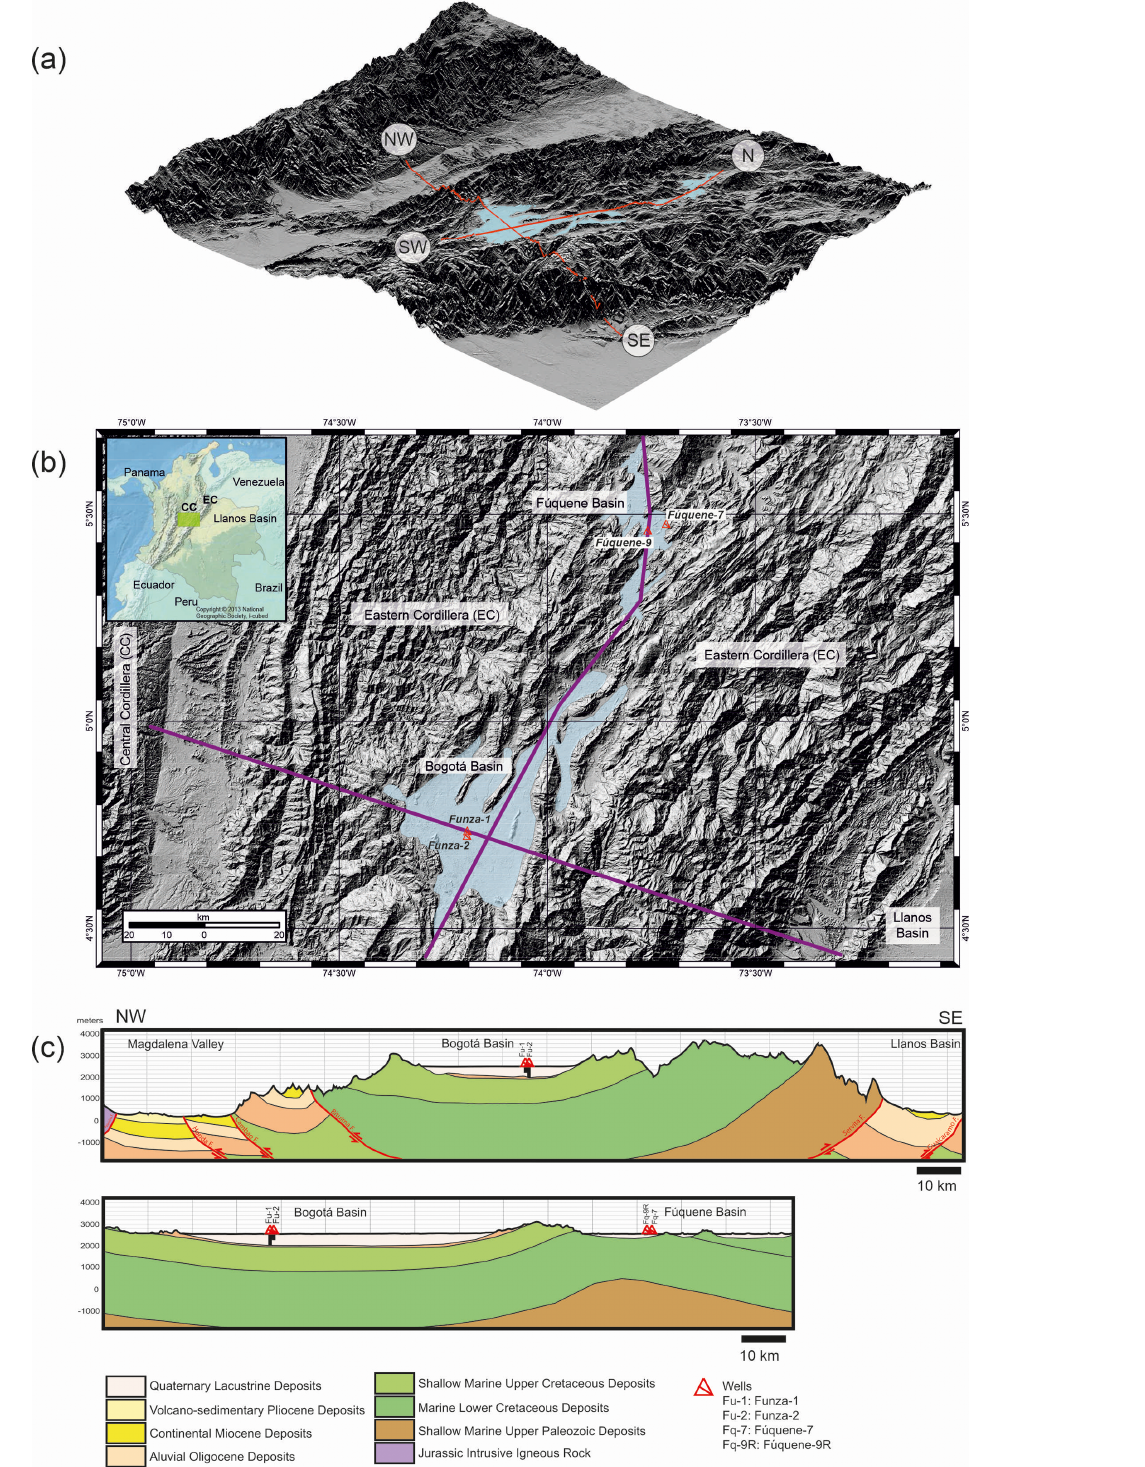
Figure 4. Cross section (a) and top view (b) of the Bogotá basin at 2550ma.s.l. (above sea level) in the Eastern Cordillera, Colombia. During the early Quaternary, an accelerated subsidence of the basin floor gave rise to the development of the ancient Lake Bogotá. The lower sediment infill contains gravels, sands, silty clays, and lignite horizons. The middle and upper part of the sediments are lacustrine silts and clays. (c) Tentative cross section of the basin of Lake Fúquene; the thickness of the sediment accumulation is unknown (figure by Gustavo Sarmiento